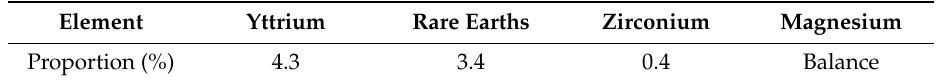
Table 1. The chemical composition of WE43.